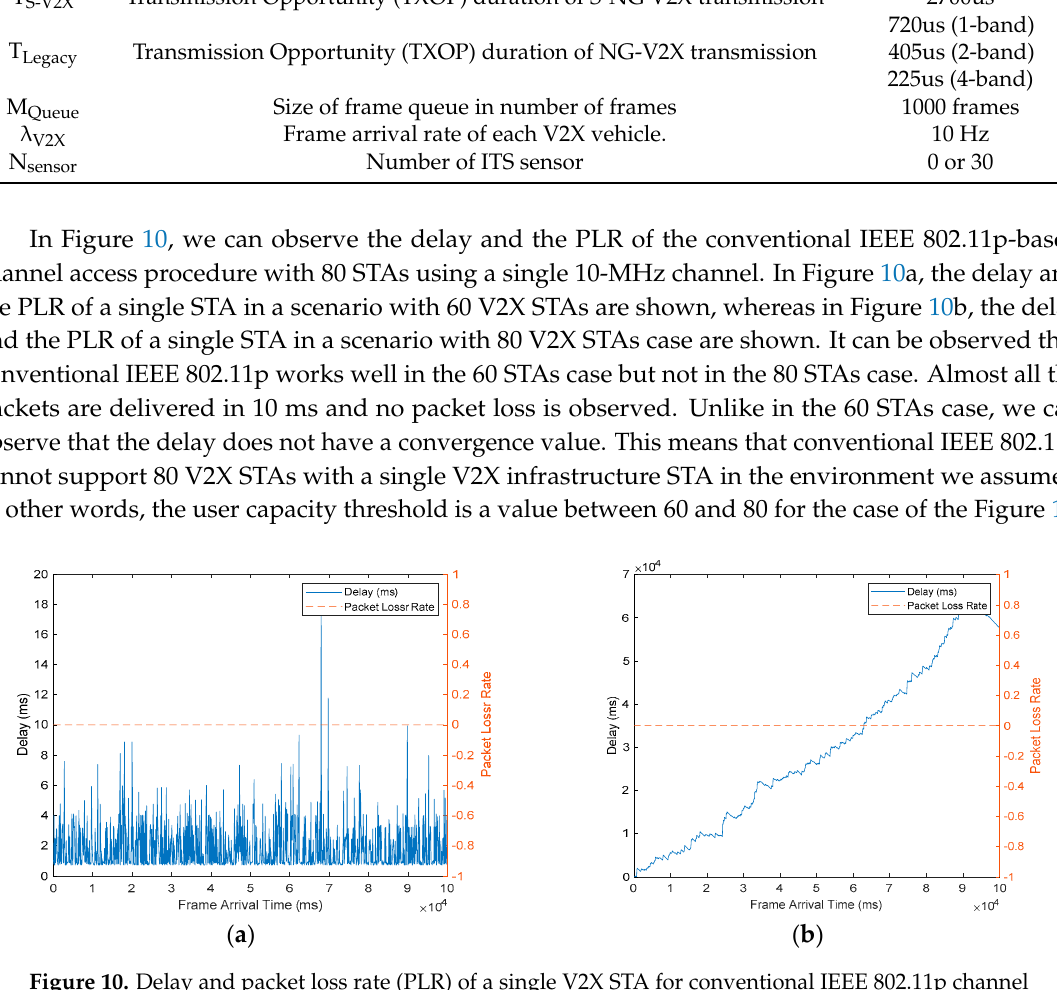
Table 1. Simulation parameters.